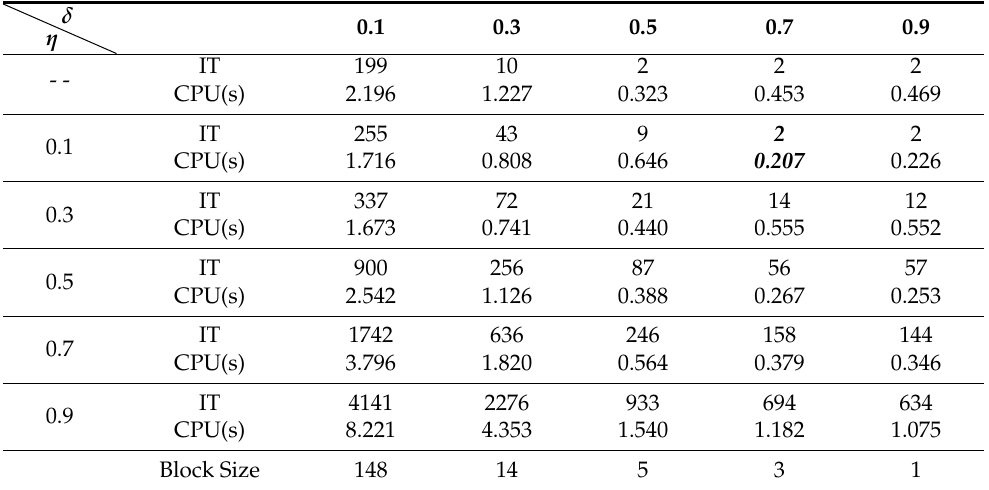
Table 3. Sensitivity analysis of BKMS( δ , η ) for system (1) with A ∈ R 5000 × 1000 .